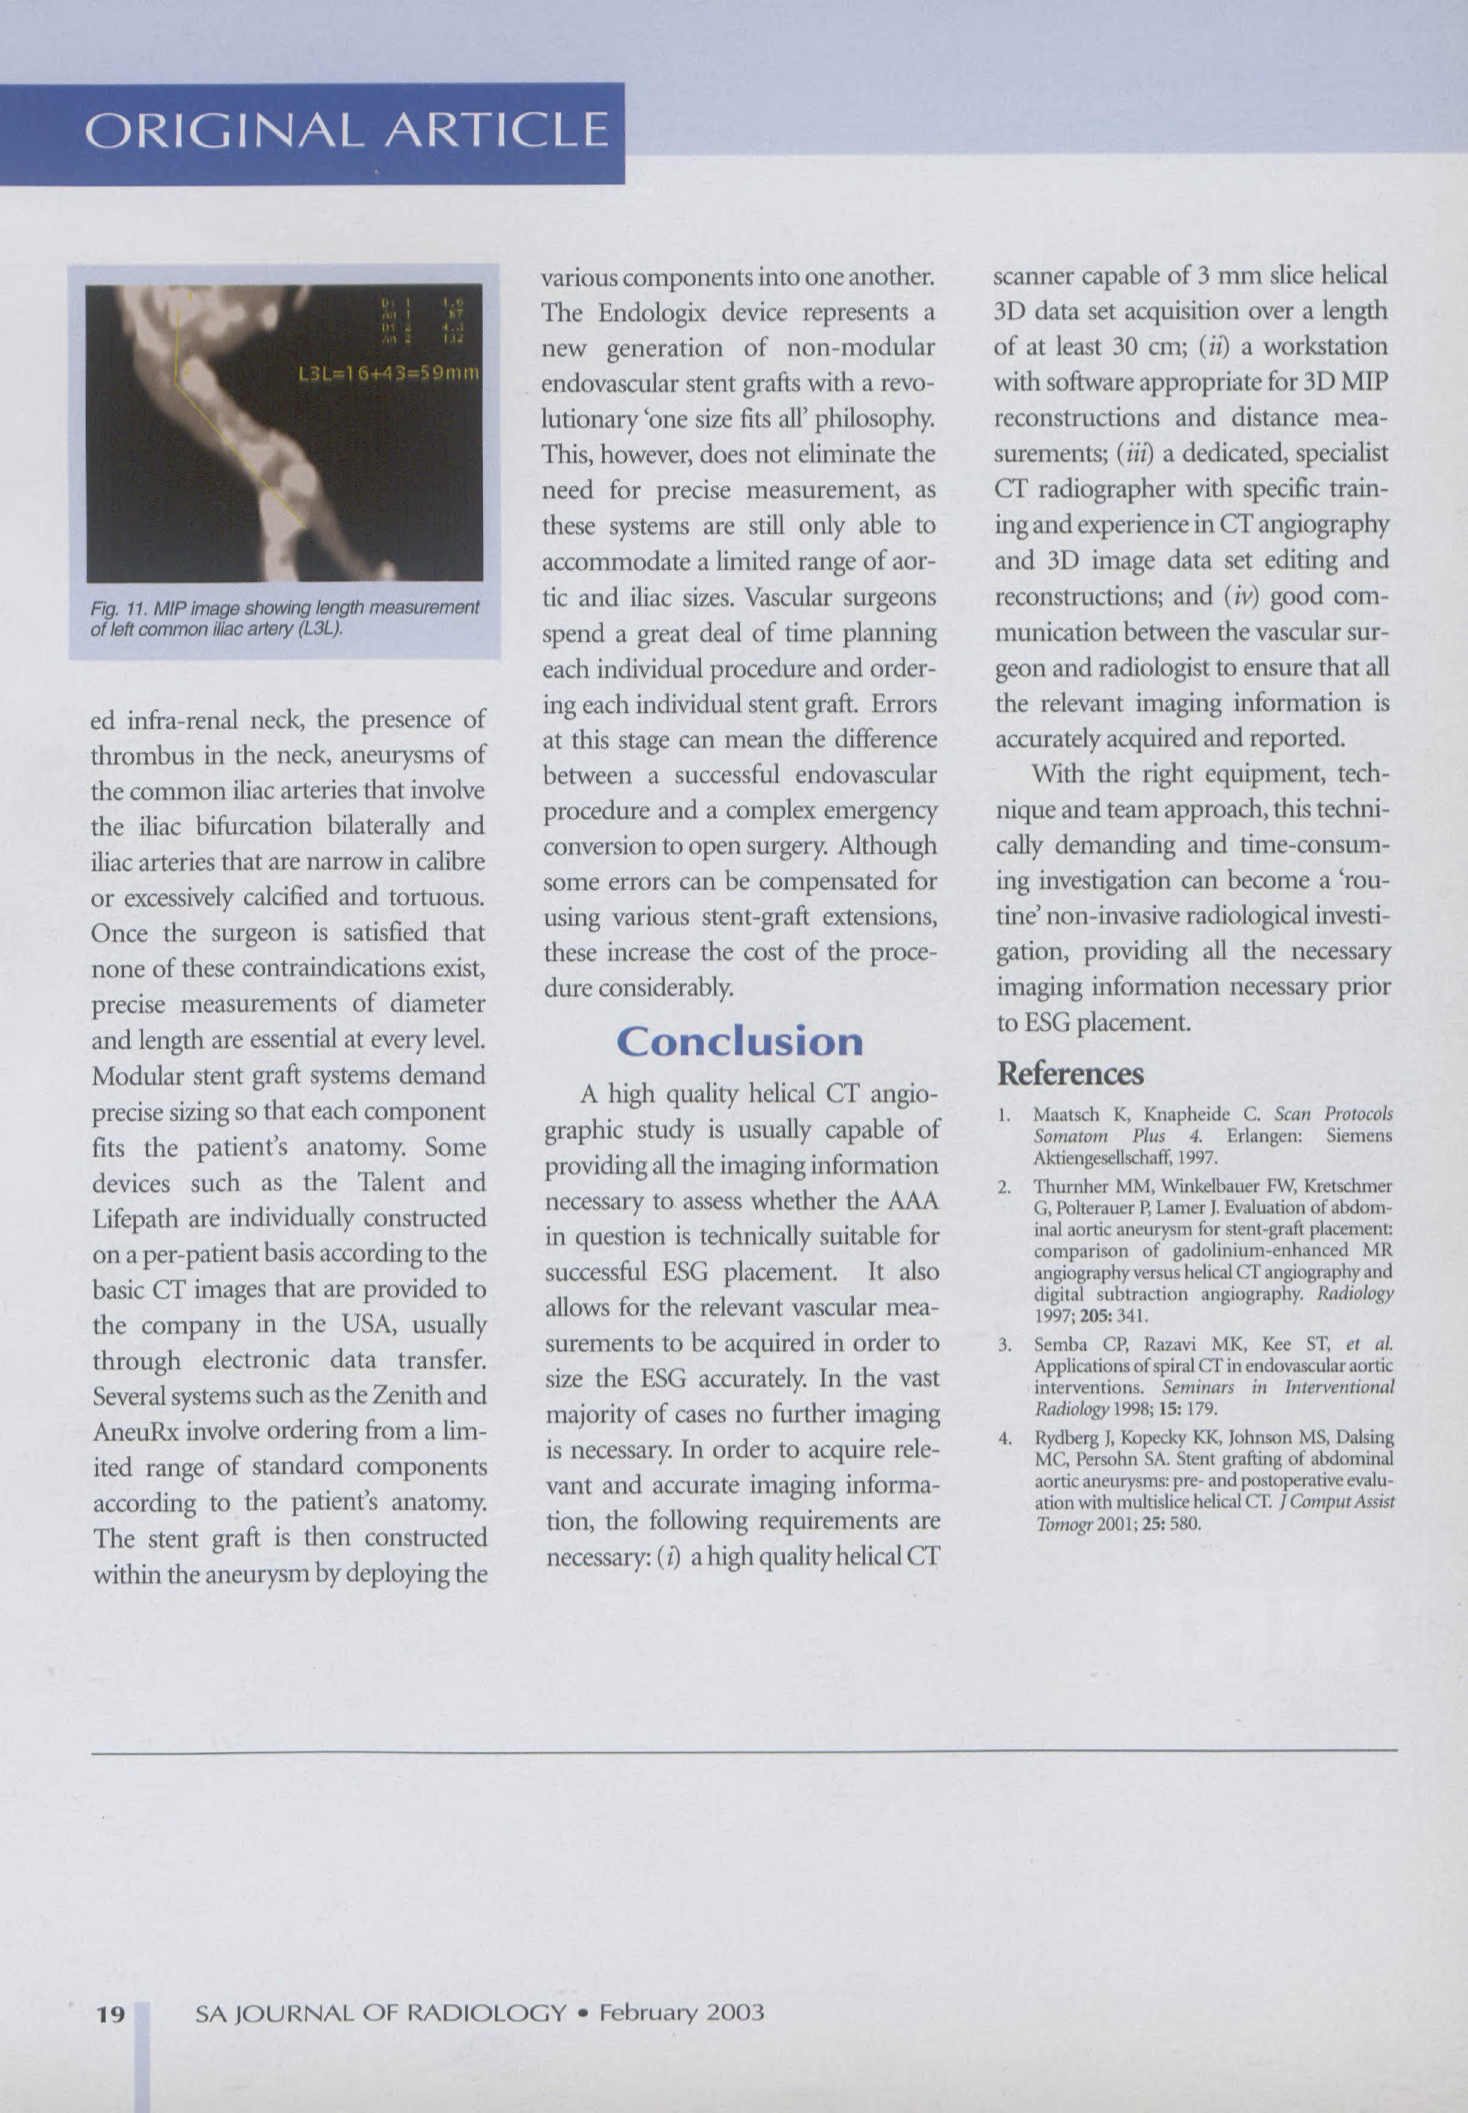
Fig. 11. MIP image showing length measurement of left common iliac artery